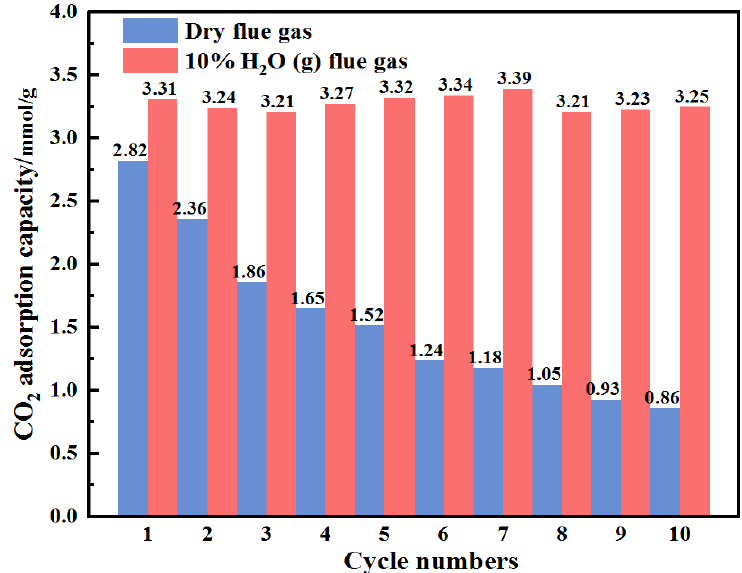
Figure 9. Ten cycles of adsorption capacity of CBC-50-TEPA in different SFGs.